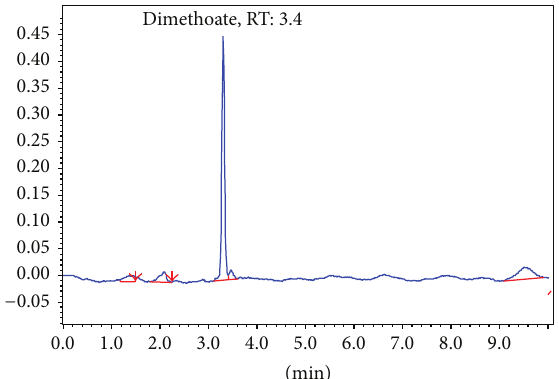
Figure1:Typicalchromatogramofadimethoatestandard(5 mg/kg) (retention time = 3.4 min).